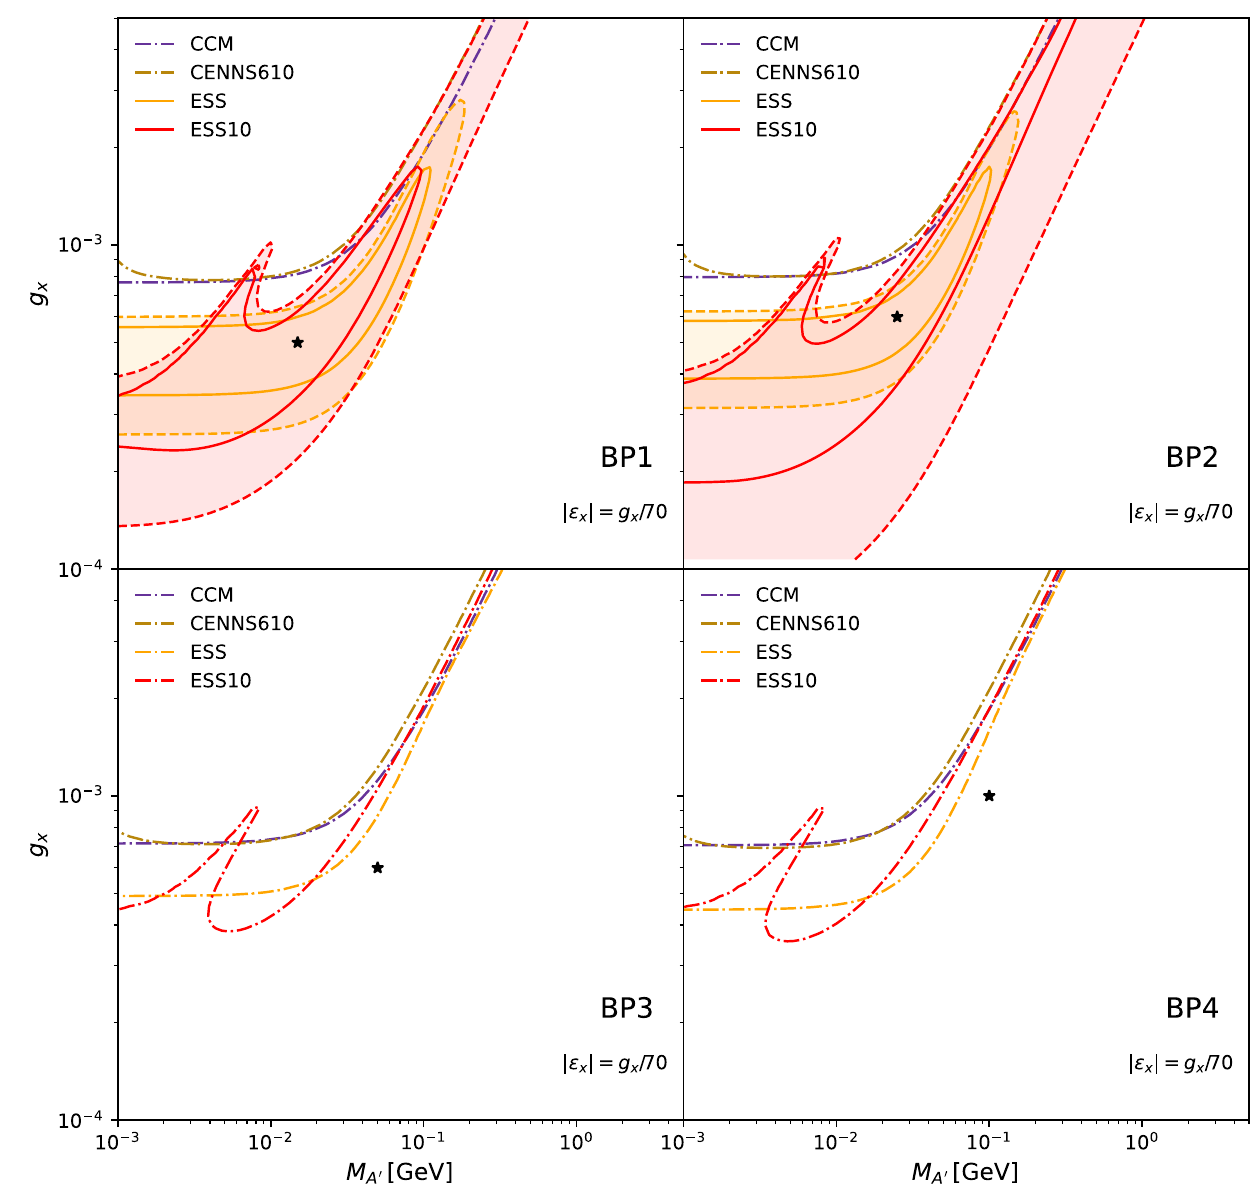
Fig. 7 Parameter reconstruction for each of the BPs of Table 1 using CE ν NS data from the experiments of Table 2 and fixing (cid:8) x = − g x / 70. The solid (dashed) contours correspond to the 68% CL (95% CL) and